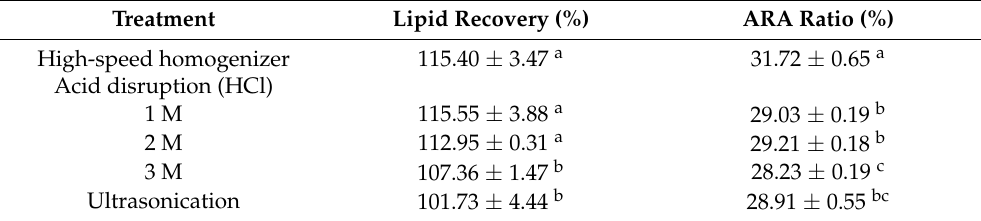
Table 1. Lipid recovery of different disruption treatments applied in M. alpina FU30797 biomass.